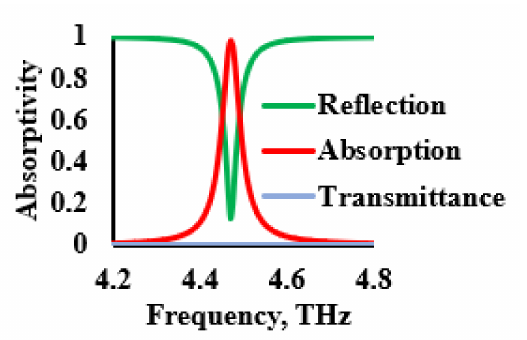
Figure 4. Absorption characteristics during different stages of evolution.